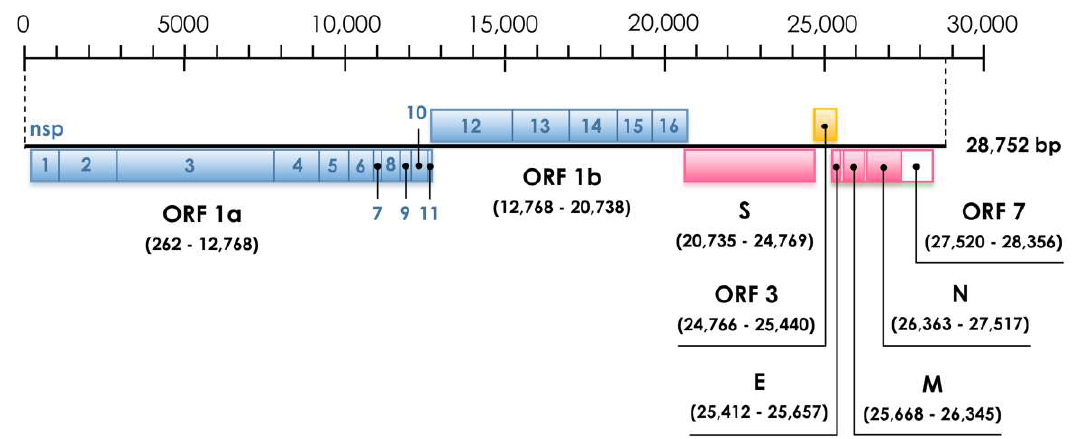
Figure 1. Genome organization and whole-genome phylogenetic analysis of novel Alphacoronavirus strain HCQD-2020. This strain contained seven open reading frames (ORFs): ORF1a, ORF1b (light blue box as nonstructural proteins); S, E, M, N (pink box as structural proteins); ORF3 (orange box as accessory protein) and unknown function ORF7 (white